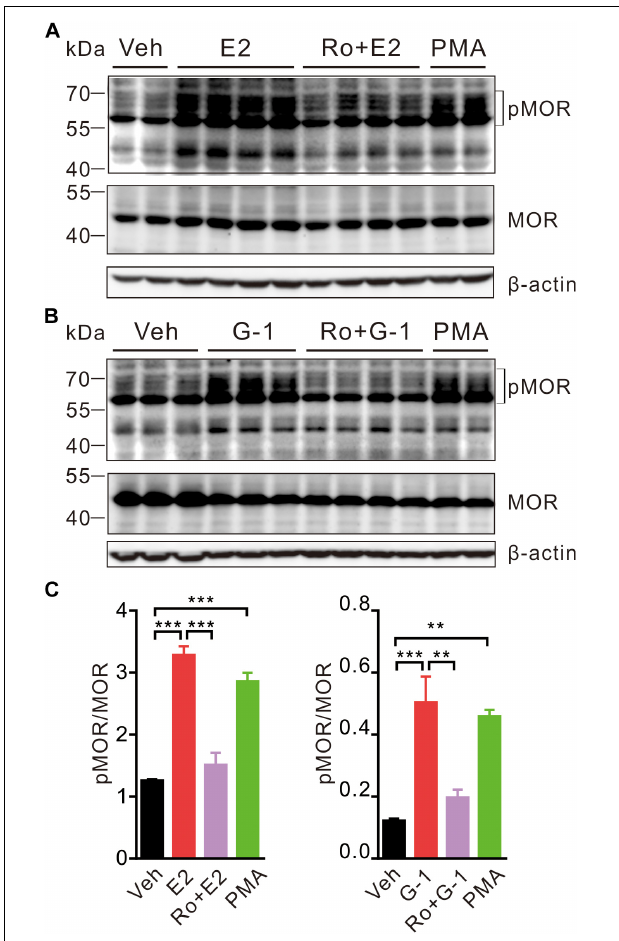
FIGURE 5 | E2 and G-1 stimulate phosphorylation of MOR in a PKC-dependent manner. (A,B) SH-SY5Y cells treated with PMA (1 µ M), E2 (1 µ M), or G-1 (1 µ M) for 30 min showed increased level of phosphorylated MOR (pMOR) as compared with the vehicle group. In the presence of the pan-PKC inhibitor (Ro 31-8820, Ro, 3 µ M), E2 and G-1 failed to increase pMOR expression. (C) The averaged pMOR level (relative to β -actin) in cells with different treatments. After detection of pMOR (A,B) , the nitrocellulose membrane was stripped and re-blocked by 5% fat-free dry milk in TBST, followed by incubation with MOR primary antibody, then MOR band was detected. ∗∗ P < 0.01, ∗∗∗ P < 0.001, one-way ANOVA with Tukey’s post hoc test, averaged data from three to four independent